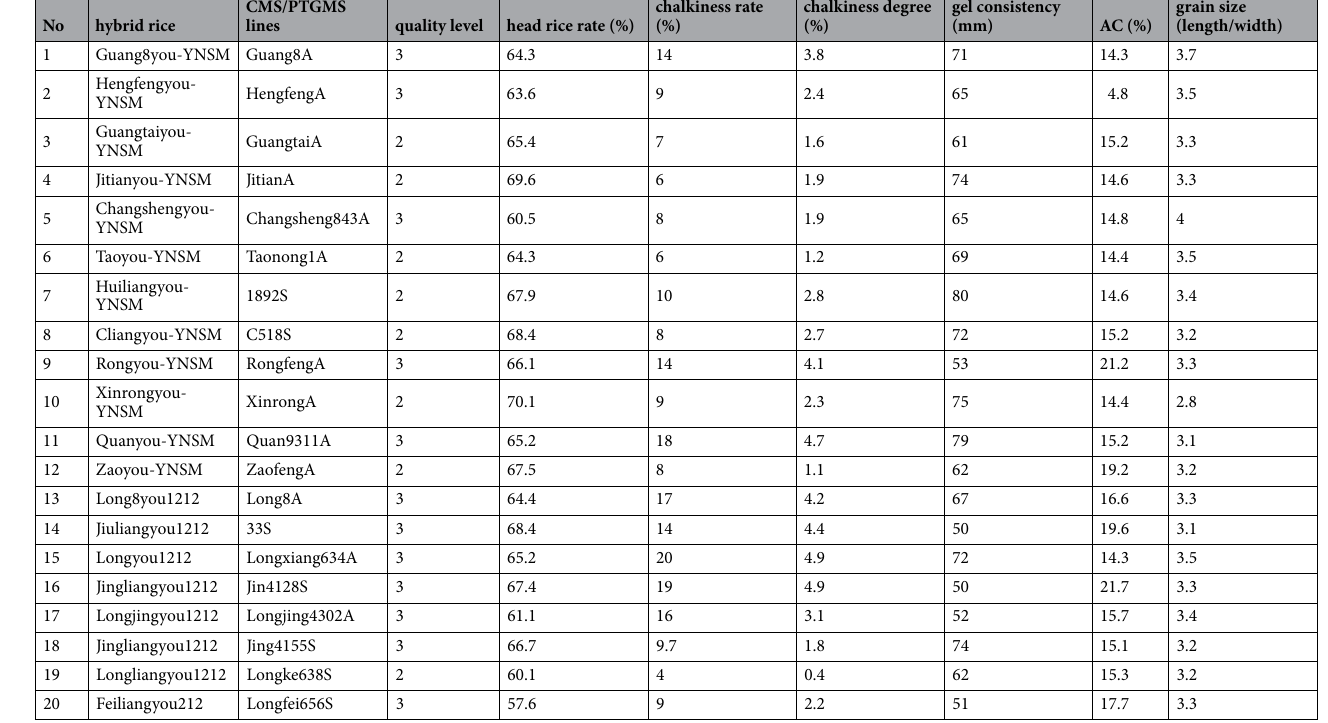
Table 4. Quality characteristics of hybrid rice with YNSM as the